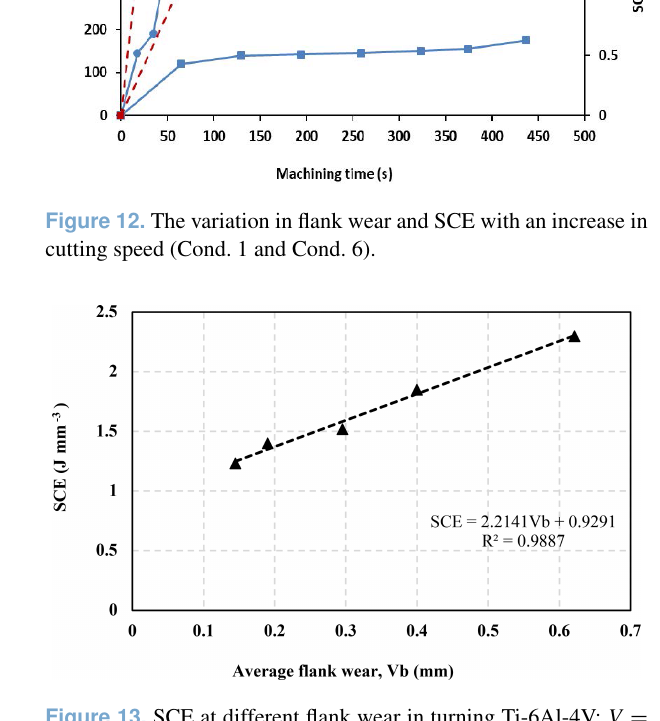
Figure 13. SCE at different flank wear in turning Ti-6Al-4V; V = 200mmin − 1 , f = 0 . 12mm per rev and d =